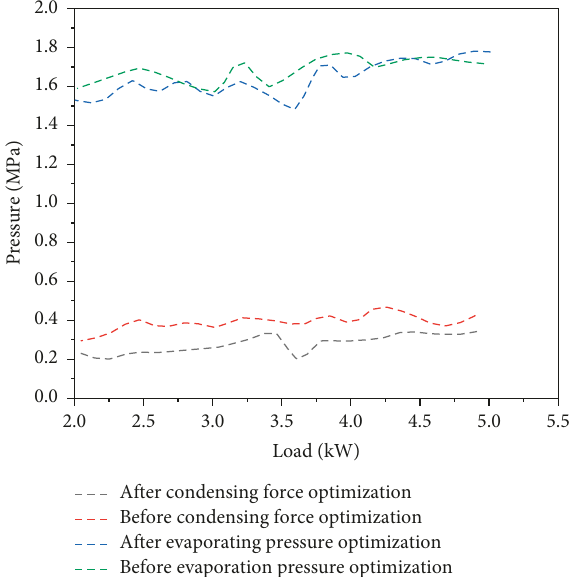
Figure 15: Evaporation and condensation temperatures of re- frigeration system before and after genetic algorithm optimization.